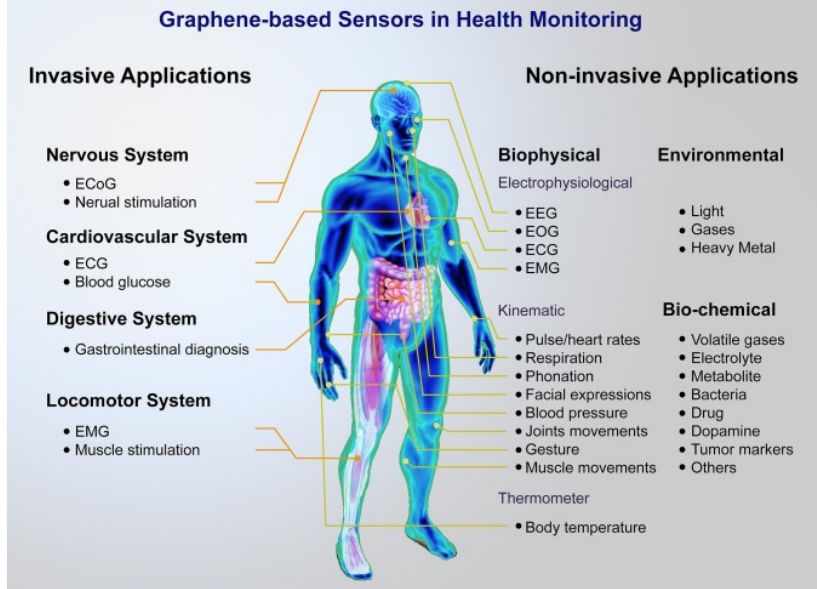
Figure 13. Brief of a graphene-based sensor platform for health monitoring; Reprinted with permission from [245]. Table 4. Fabrication and properties of graphene-based materials used in wearable technology. Material